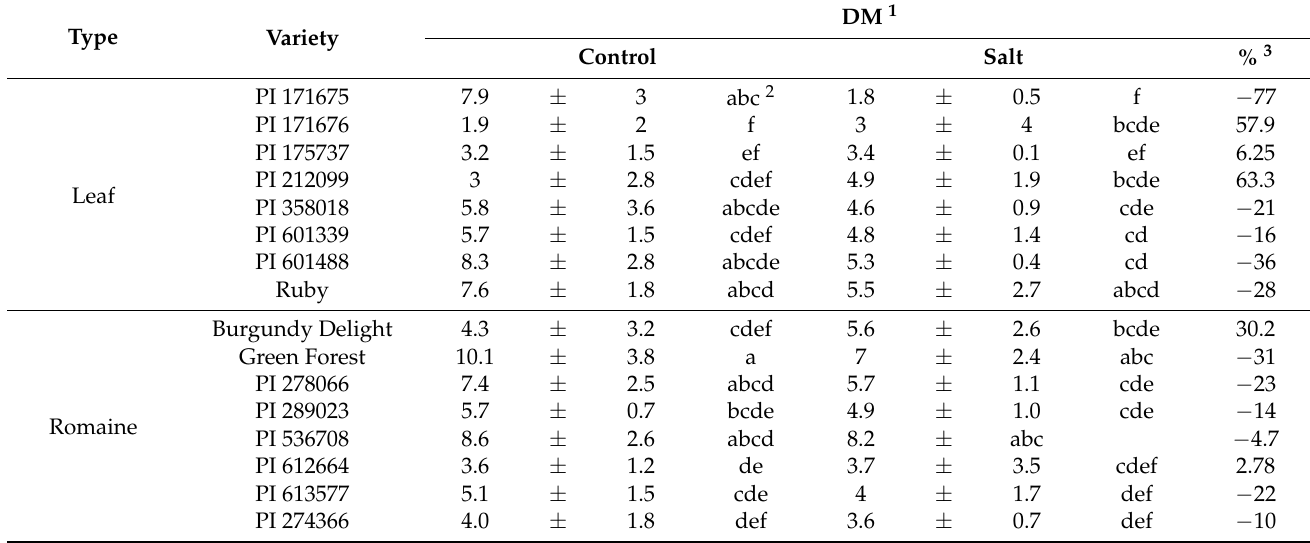
1 Dry mass (in gram) on per plant basis. 2 Means followed by different letters are significantly different from each other ( p < 0.05) as assessed by Tukey’s test. 3 % indicates the percentage change in each variety due to change in treatment levels (Control vs. Salt), where negative sign ( − ) indicates a percentage decrease in